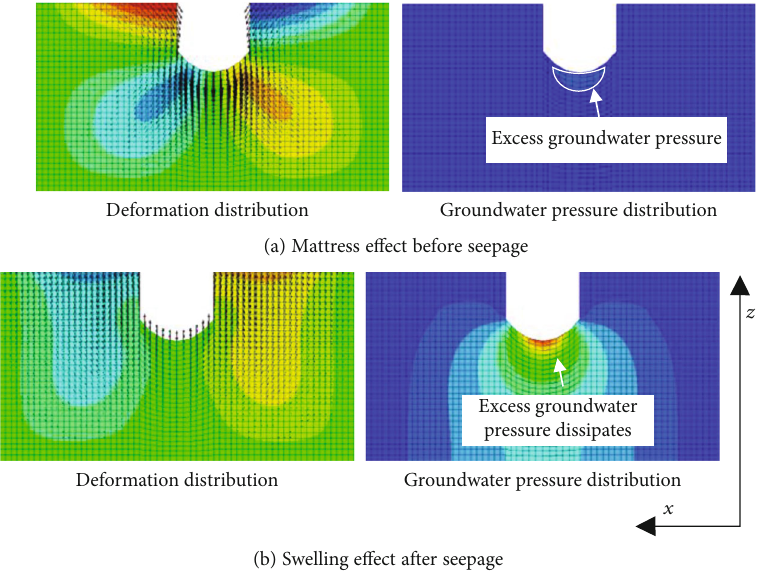
Figure 11: Deformation mechanism of the slope during